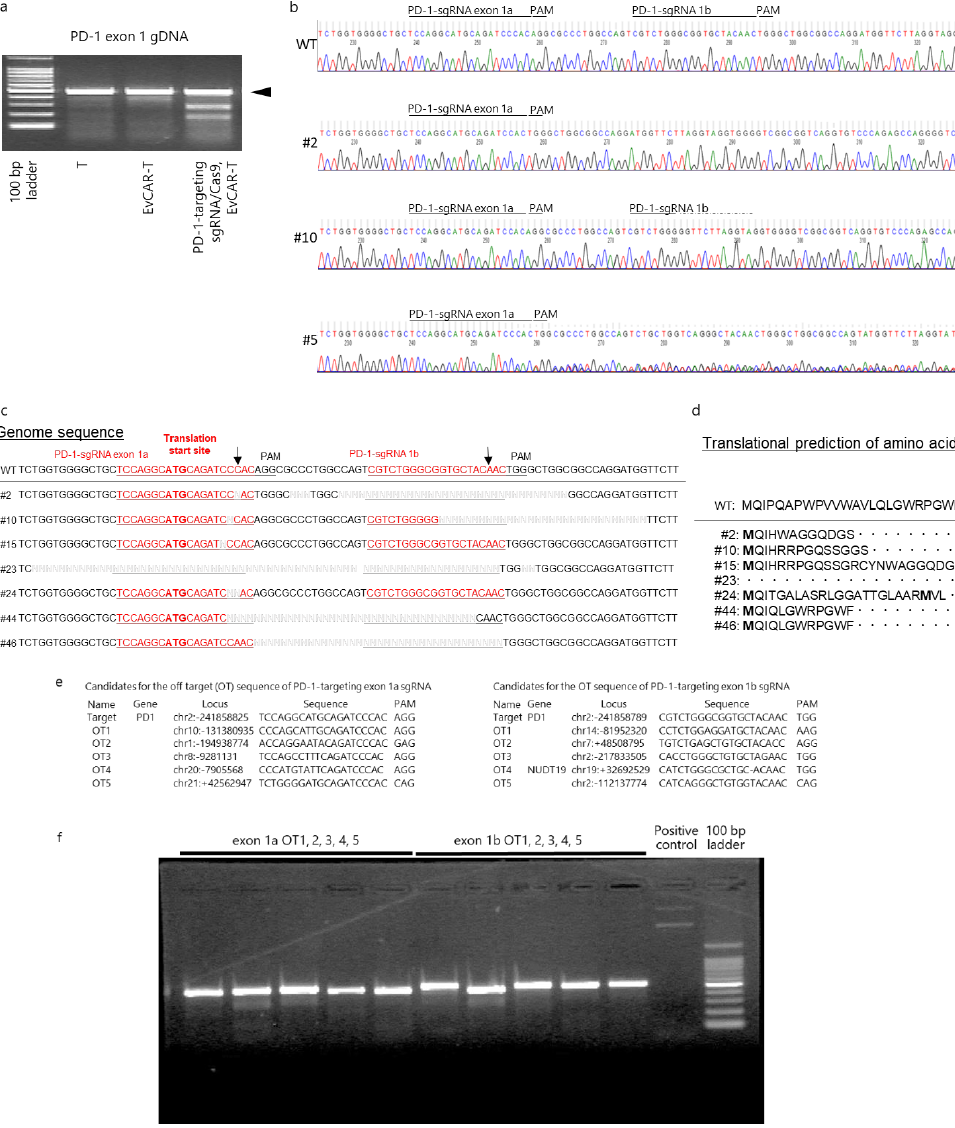
Figure 3. Genomic PD-1 exon 1 disruption in EvCAR-T cells transduced with the PD-1-targeting sgRNA/Cas9 vectors ( a ) PCR products were amplified and subjected to mutation detection assay. The electrophoresis bands represent the 100-bp ladder, control T cell populations, EvCAR-transduced T